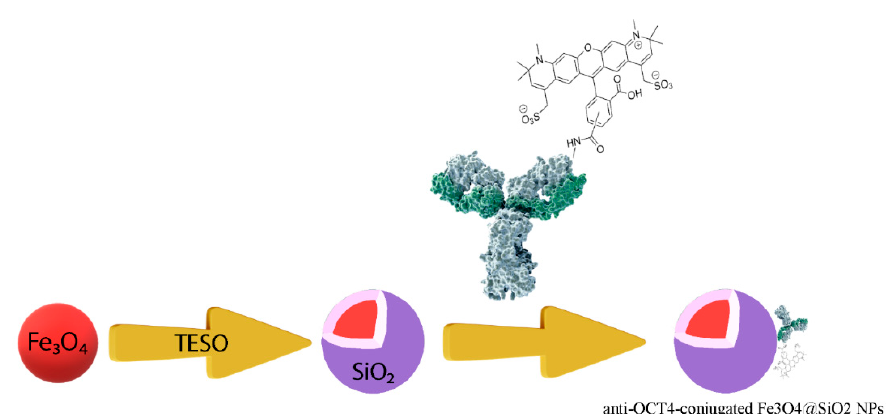
Figure 9. The procedure for preparing anti-Oct4 antibody-conjugated iron nanoparticles. TEOS: tetraethyl orthosilicate.